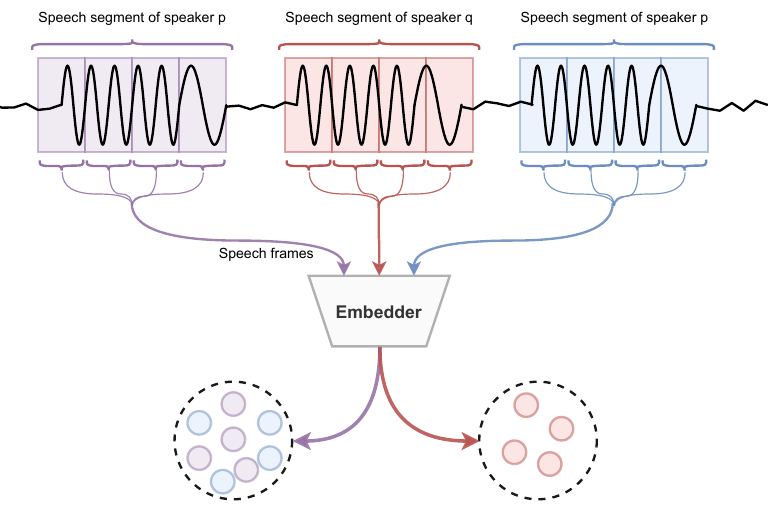
Figure 1. The figure illustrates a set of segmented speech with an unknown number of speakers (in the example, two speakers, p and q). Speech segments are windowed into smaller speech frames, assuming that all frames of a single speech segment belong to a single class. Further, a DL-based embedding system finds speech similarities (inter-segment similarity) and relations from speech segments. The process results in generating clusterable speaker